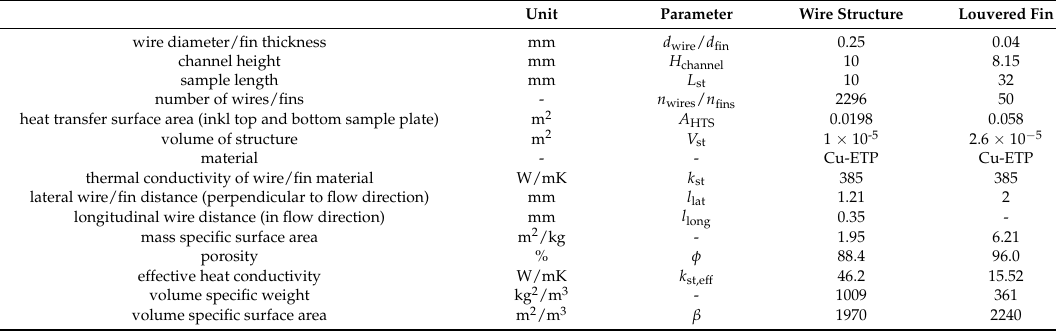
Table 2. Morphological parameters for the test samples.